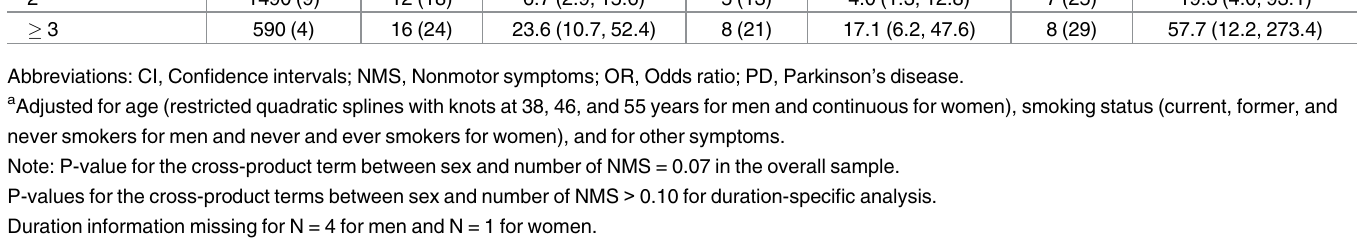
Duration information missing for N = 4 for men and N = 1 for